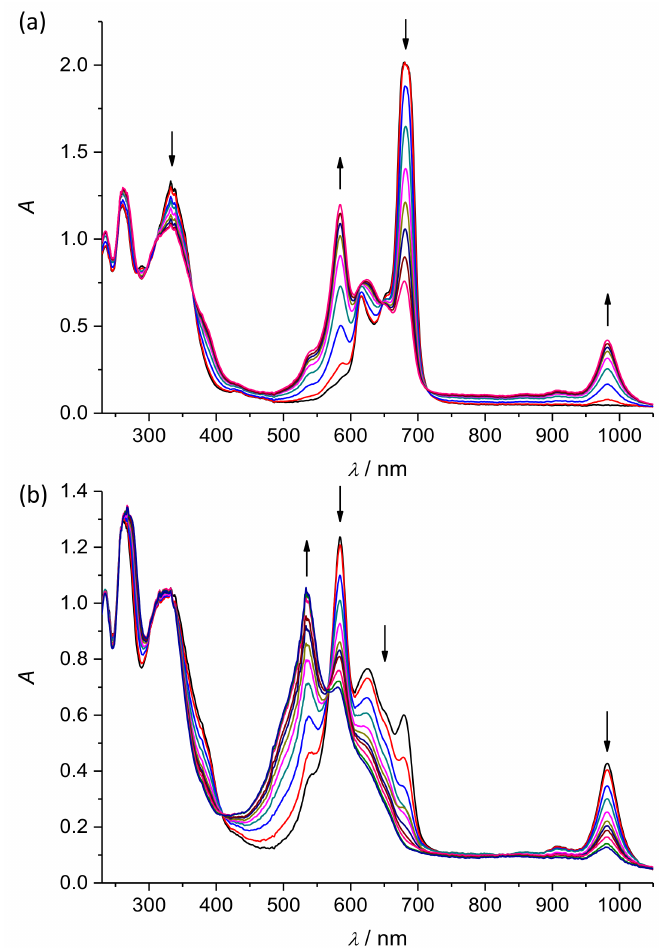
Figure 3. ( a ) Evolution of UV-vis-NIR spectra in 2D projection upon forward scan in the region of the first reduction peak for complex 9 (Ni − Zr) in ACN/ n -Bu 4 NPF 6 (black trace: − 0.85 V, red trace: − 0.90 V, blue trace: − 0.95 V, dark cyan trace: − 1.00 V, magenta trace: − 1.05 V, dark yellow trace: − 1.10 V, navy trace: − 1.15 V, wine trace: − 1.20 V, pink trace: − 1.25 V, all vs. Fc + /Fc); ( b ) evolution of UV-vis-NIR spectra in 2D projection upon forward scan in the region of the second reduction peak for 9 (black trace: − 1.30 V, red trace: − 1.35 V, blue trace: − 1.40 V, dark cyan trace: − 1.45 V, magenta trace: − 1.50 V, dark yellow trace: − 1.55 V, navy trace: − 1.60 V, wine trace: − 1.65 V, pink trace: − 1.70 V, olive trace: − 1.75 V, royal trace: − 1.80 V, all vs. Fc +